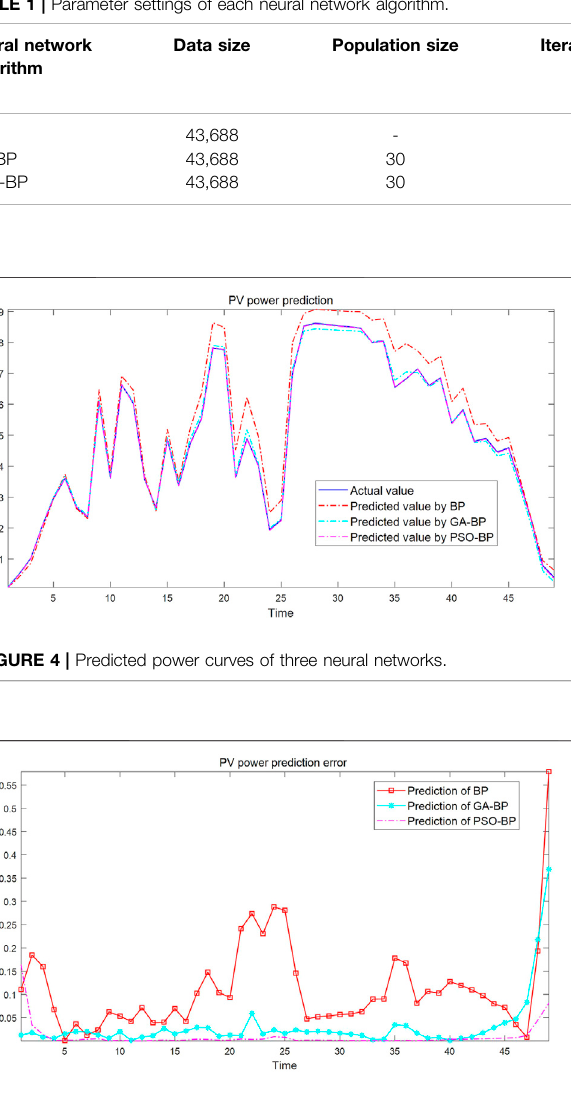
FIGURE 5 | MAPE of three PV power prediction